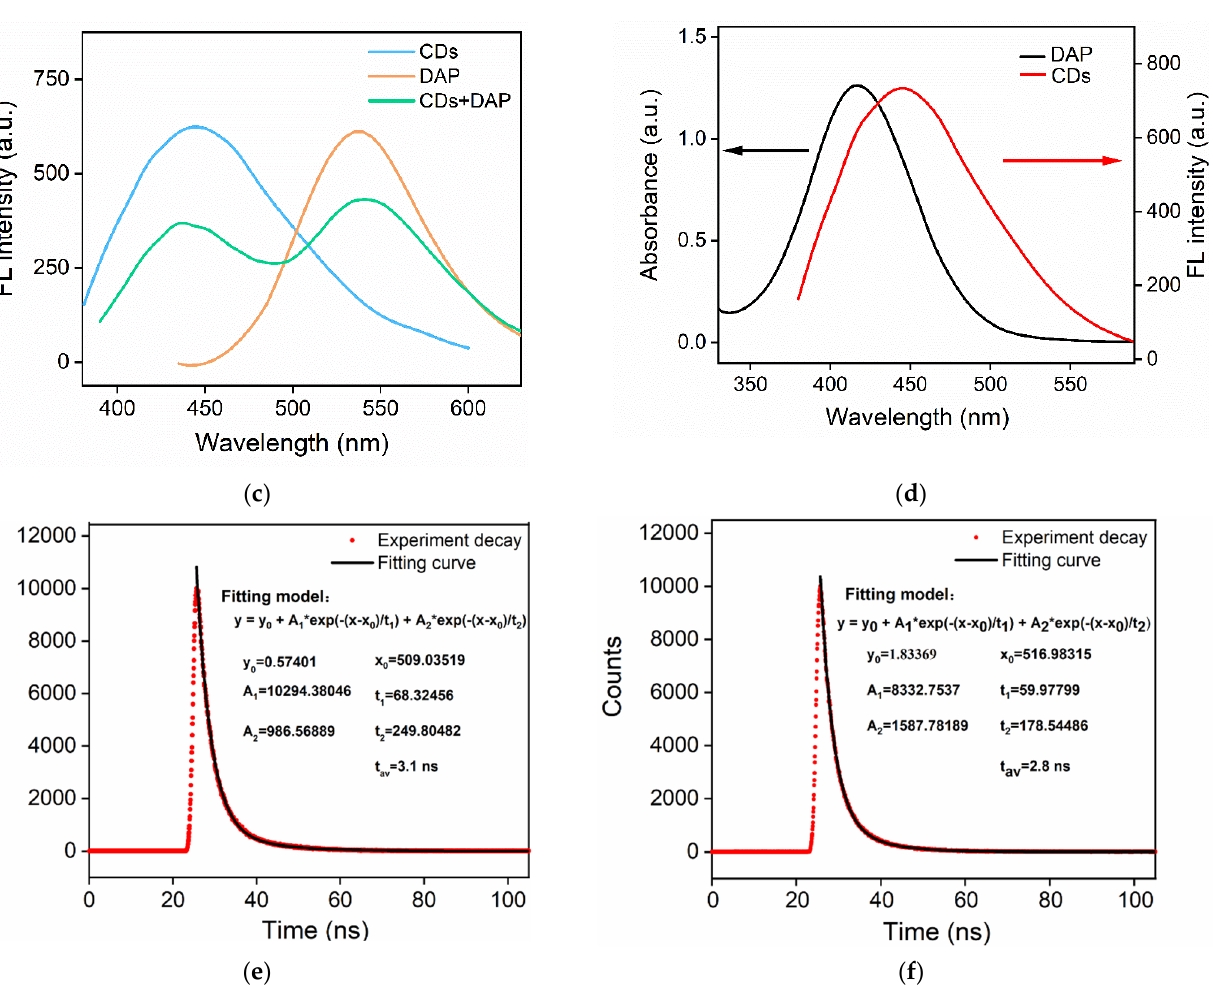
Figure 6. ( a ) A 652 obtained in the absence (blank) or presence of the capture agent of ROS. ( b ) ESR spectra obtained in the mixture of DMPO and H 2 O 2 in the absence or presence of CDs. ( c ) Fluores- cence emission spectra of CDs (15 μ g/mL), DAP (0.5 mM), and CDs (15 μ g/mL) + DAP (formed in the presence of 50 μ M H 2 O 2 and 7.5 mM OPD). ( d ) The absorbance spectra of DAP and the fluores- cence emission spectrum of CDs. ( e , f ) Fluorescence lifetime spectra of CDs in the absence ( e ) or presence of DAP ( f ).